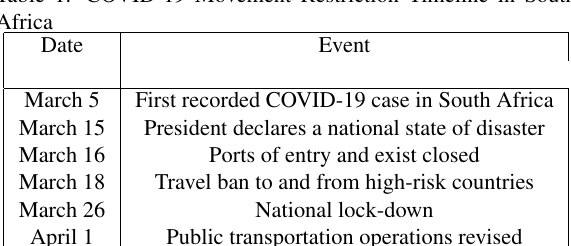
Table 1: COVID-19 Movement Restriction Timeline in South